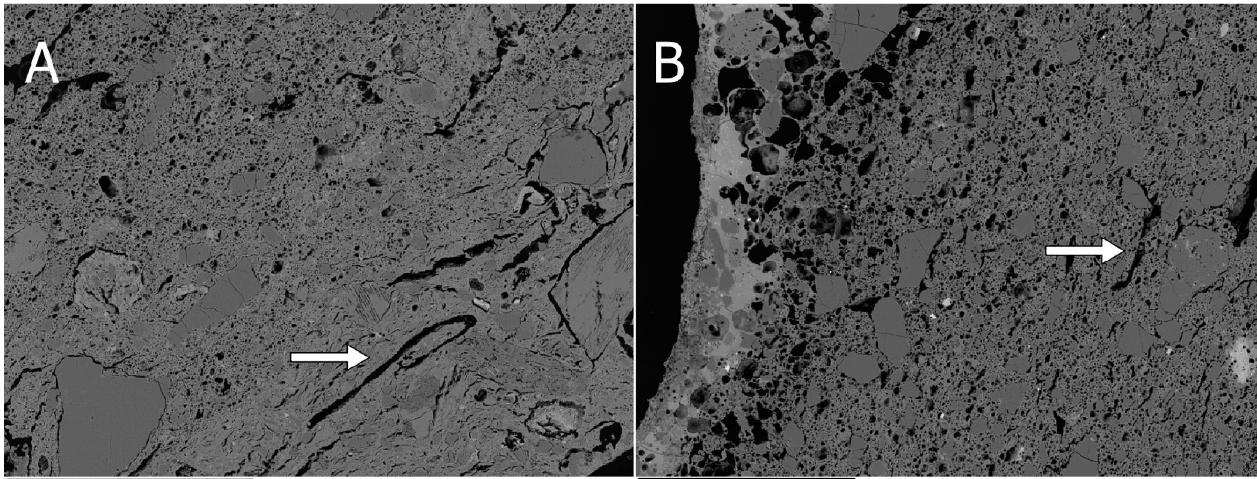
Fig 4. BSE micrograph of H12 (A) and G10 (B) with evidence of burnt out organic inclusions in the ceramic paste. (Scales = 1mm).